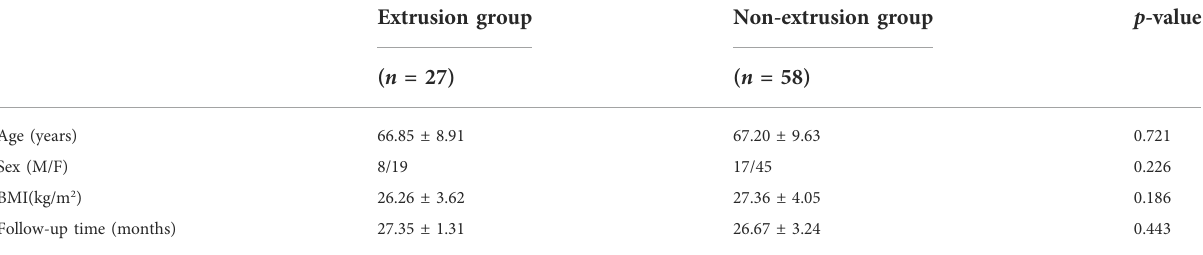
TABLE 1 Comparison of preoperative baseline characteristics of the two